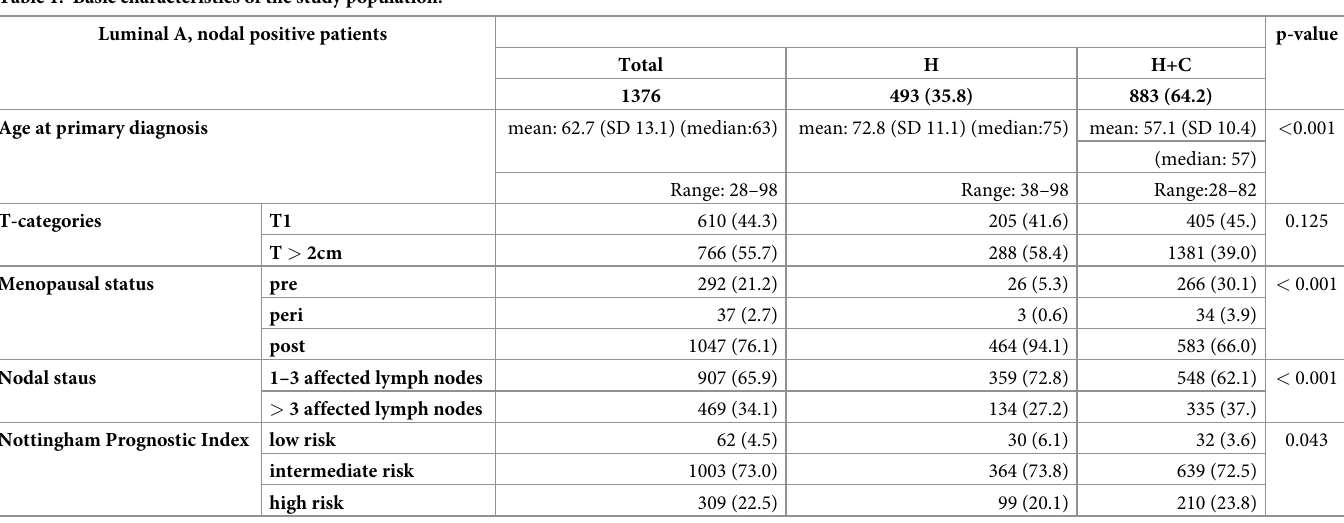
Table 1. Basic characteristics of the study population. Luminal A, nodal positive